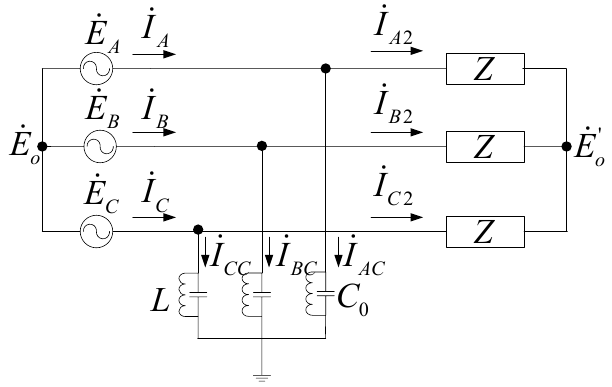
Figure 5. The equivalent circuit of PT’s ferroresonance, considering the